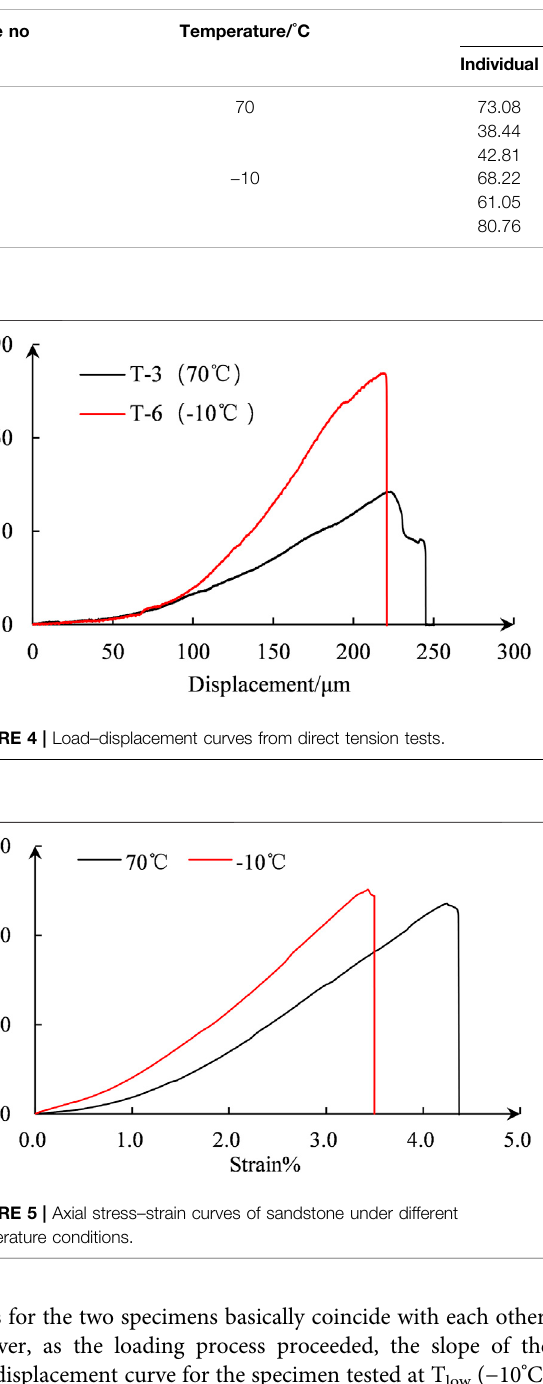
TABLE 1 | Testing values of tensile strength.